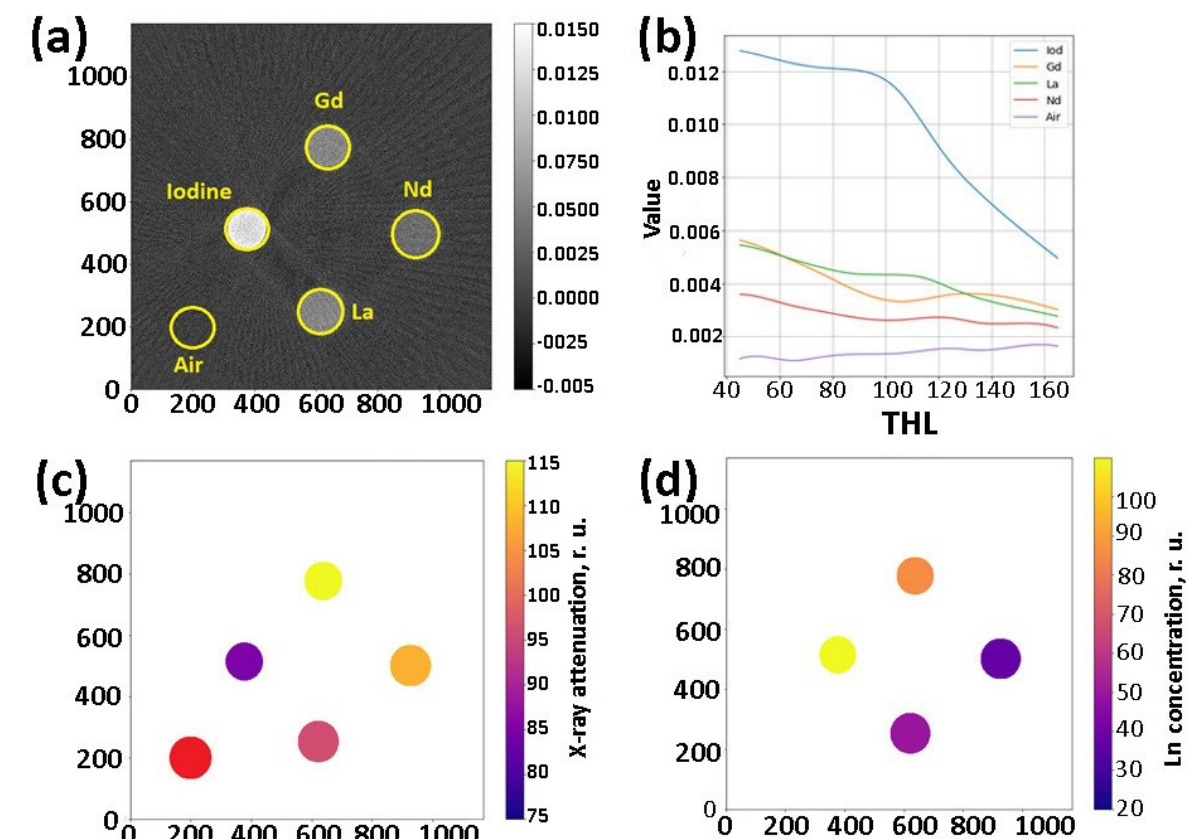
Figure 8. ( a ) CT image of the phantom at 45 thl, ( b ) dependence of gamma radiation absorption on the energy (detector threshold) in the ROI, ( c ) application of the criterion, and ( d ) evaluation of the molar concentration of the CA. Water solutions with the following concentrations of the contrasting elements were used: iodine — 140 mg·mL −1 , Gd — 74 mg·mL − 1 , La — 40 mg·mL −1 , and Nd — 40 mg·mL −1 .